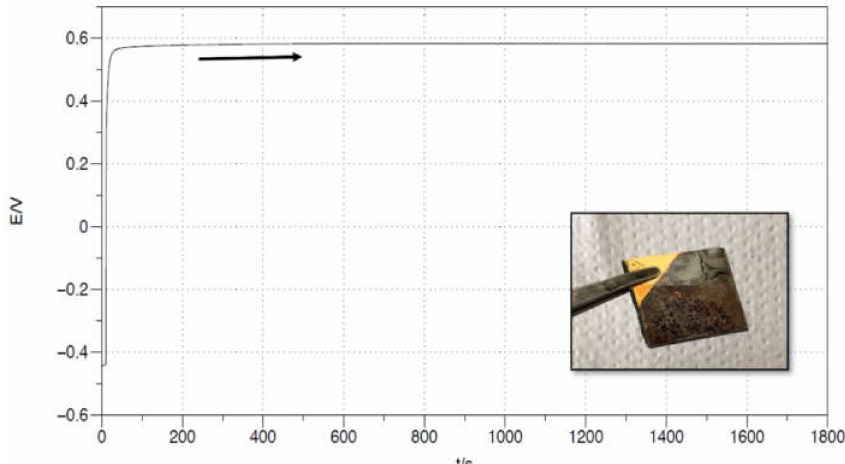
Figure 8. PANI galvanostatic electropolymerization on a Fe 3 O 4 /Au WE, in a 3-electrodes cell. Pt was used as CE, Ag/AgCl/KCl sat as Ref. The electrolyte consisted in the basic aniline solution (pH = 13) previously studied in Figure 5: Na(OH) (0.1 M) and aniline (0.1 M). A constant current of 0.6 mA was applied for 1800 s. The inset displays the produced